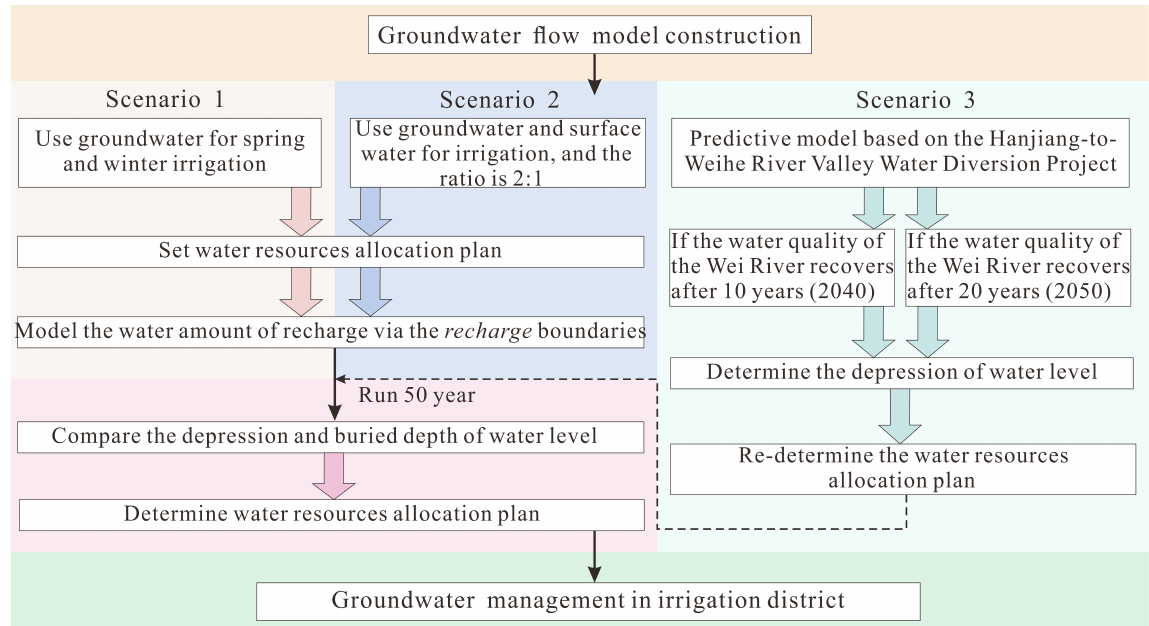
Figure 5. Model simulations—scenarios 1, 2, and